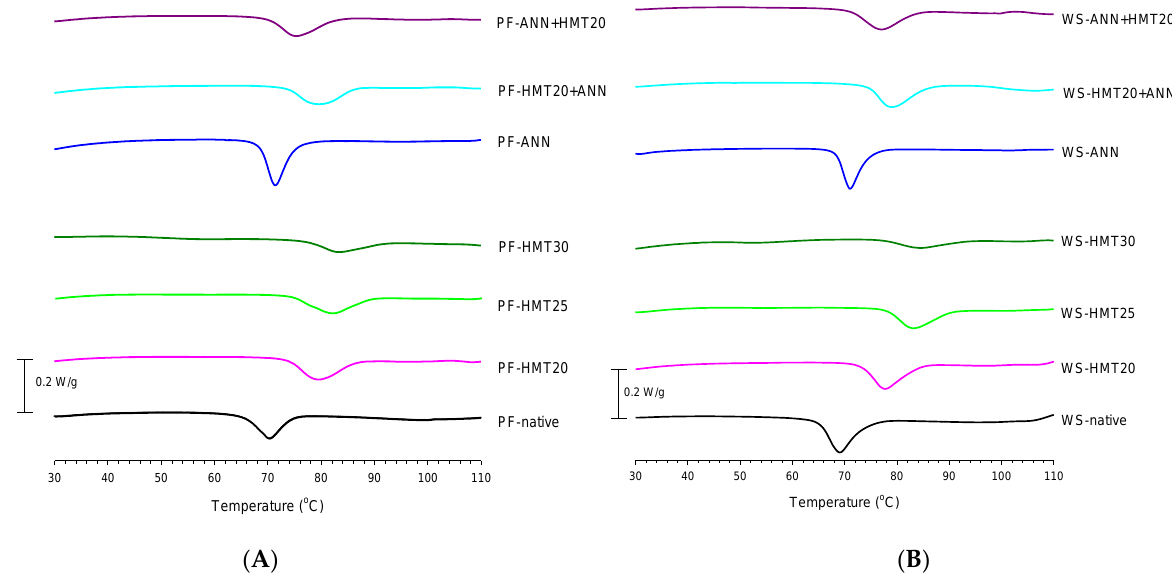
Figure 5. Effect of heat-moisture treatment and annealing on the differential scanning calorimetry of Tsai-ou and Shih-lian starches. ( A ) PF indicates Tsai-ou lotus rhizome starch. ( B ) WS indicates Shih-lian lotus rhizome starch. HMT indicates heat-moisture treatment. The numbers 20, 25 and 30 indicate the moisture levels under HMT. ANN indicates annealing.